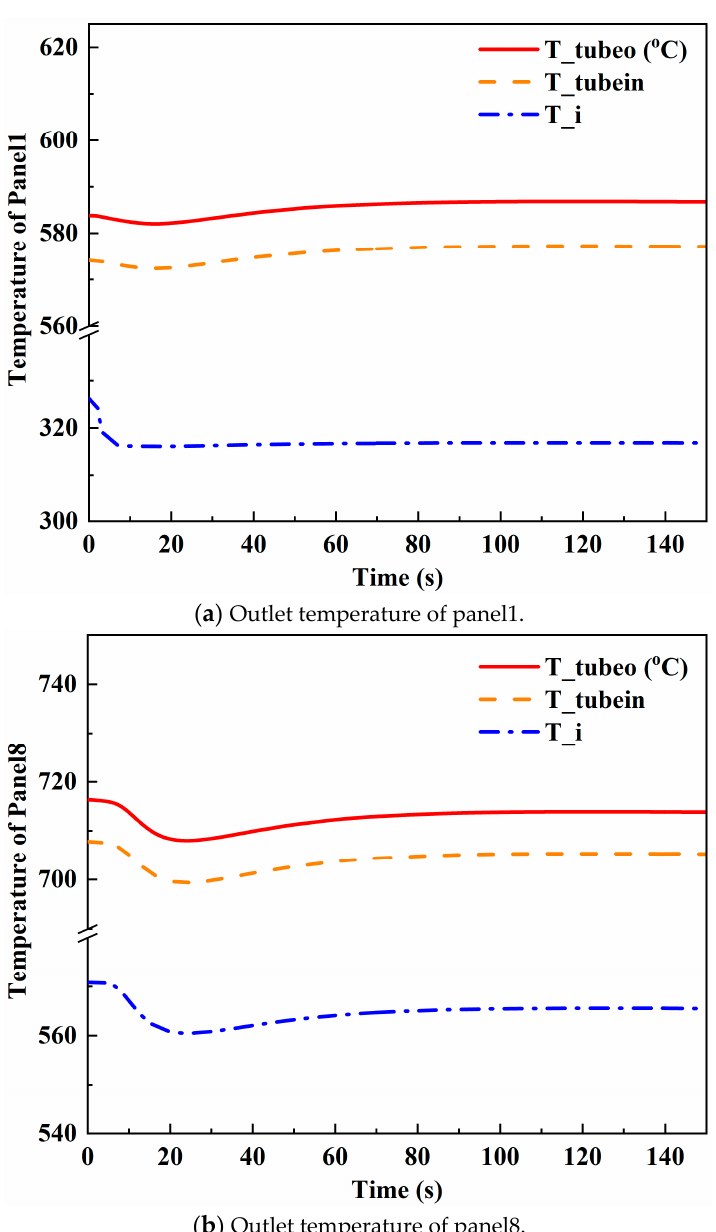
Figure 7. Influence of molten salt inlet temperature disturbance.